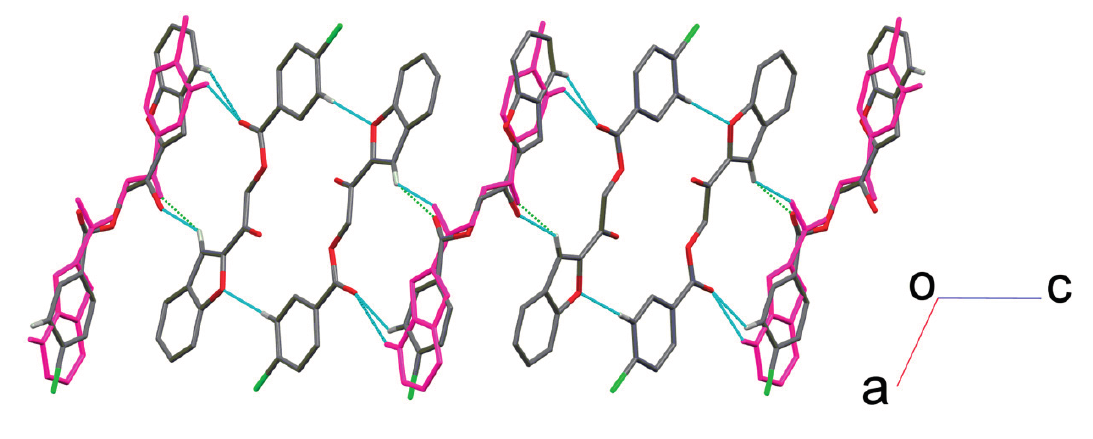
Figure 6. Hydrogen-bonded infinite chain in 4b . Blue dotted lines are weak C–H···O hydrogen bonds. The minor component of disordered molecule B is shown in pink.